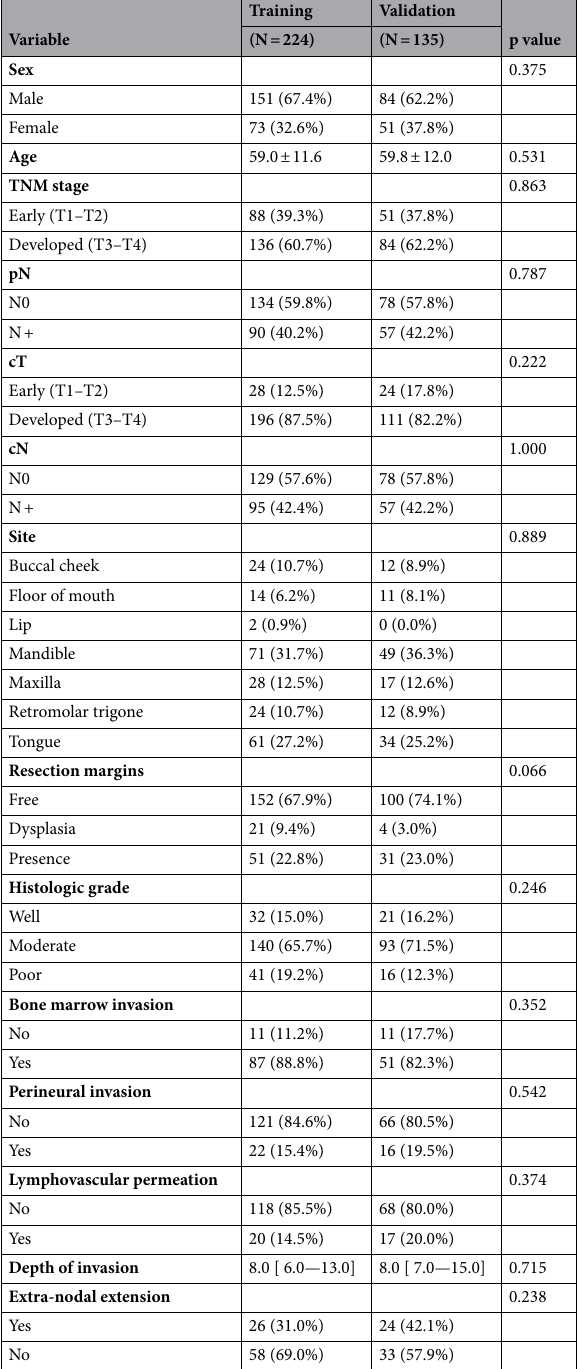
Table 2. Baseline characteristics, training and validation groups. Data were reported as mean ± standard deviation (SD) or median [Q1–Q3] for continuous variables and n (%) for categorical variables. P values were calculated by Student’s t-test or Mann–Whitney U test for continuous variables and chi-square test or Fisher’s exact test for categorical variables. pN pathologic N, cT clinical T, cN clinical